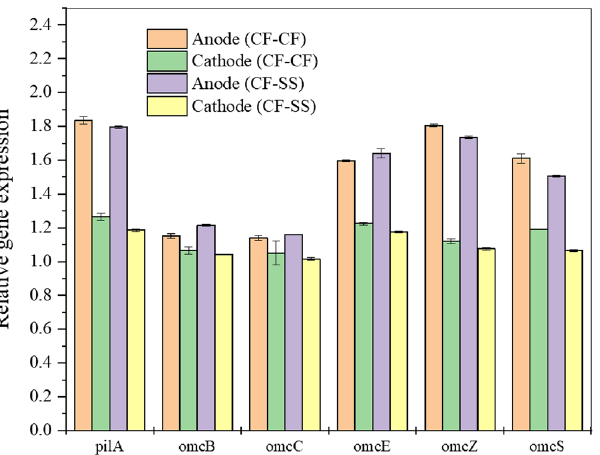
Figure 6. Expression of genes known to regulate extracellular electron transfer in biofilms. The error bars indicate the standard deviation of three replicates (n =